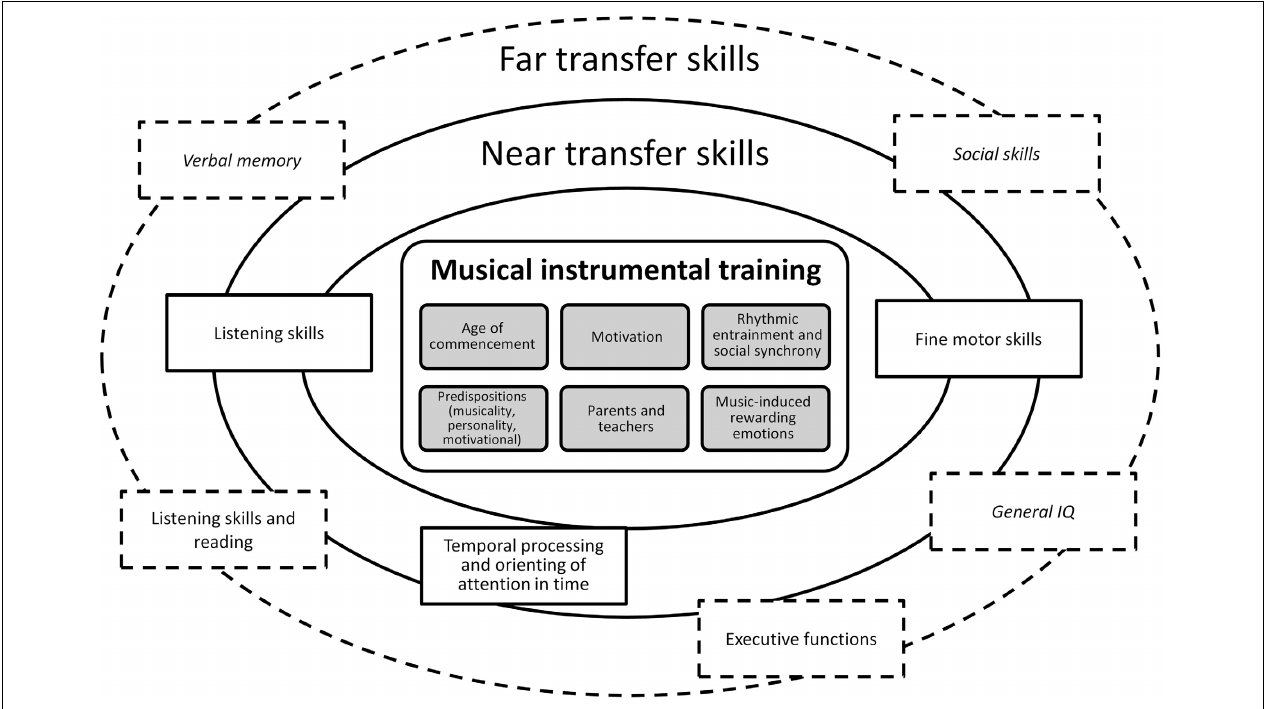
FIGURE 1 | Schematic representation of near and far transfer skills that benefit from musical instrumental training. In the inner rectangle variables modulating the influence of musical training on cognitive development are listed (see main text, in particular section Variables Modulating Brain